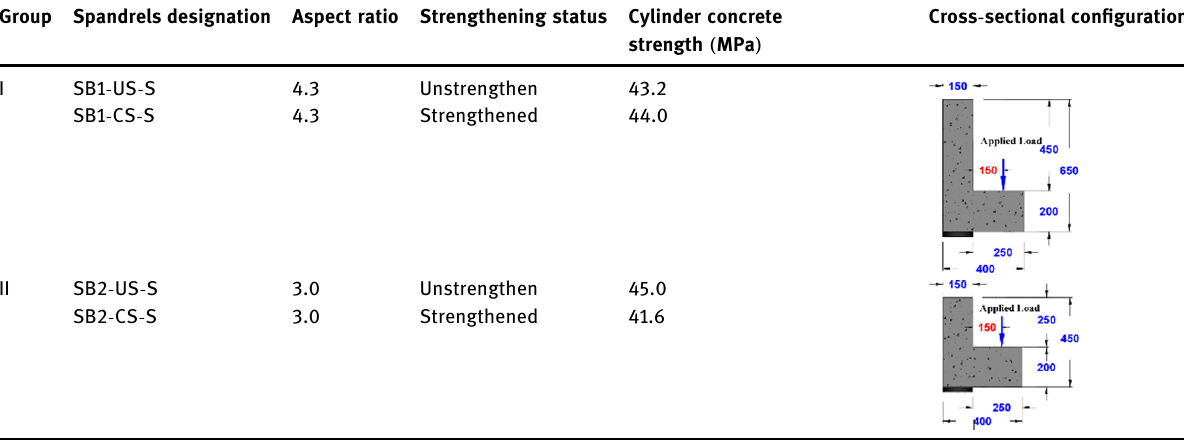
Table 1: Properties of spandrel beams Group Spandrels designation Aspect ratio Strengthening status Cylinder concrete